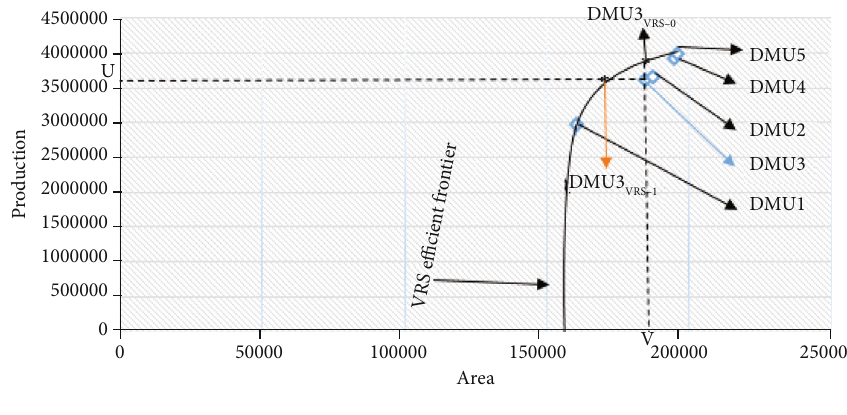
Figure 3: DEA dealings (TES).